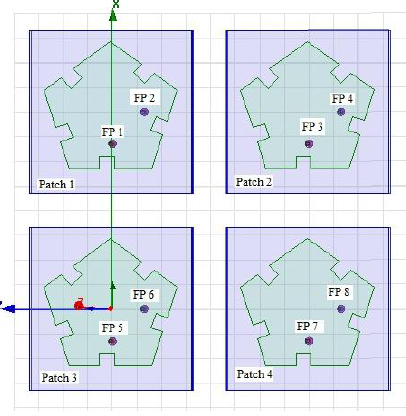
Figure 12. Planar antenna array (2 × 2, dx = dy = 0.5) The simulated return loss (S 11 to S 88 ) and mutual coupling or isolation (S 11 , S 31 , S 51 , S 71 ) for the 2 × 2 planar array using HFSS are shown in Figure 13 and 14 respectively. Each